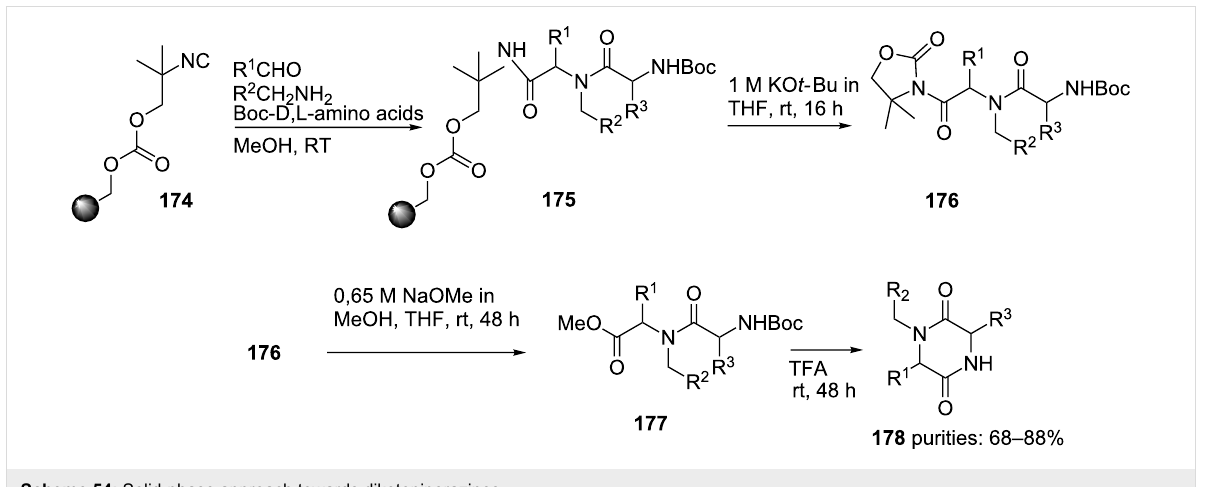
Scheme 54: Solid-phase approach towards